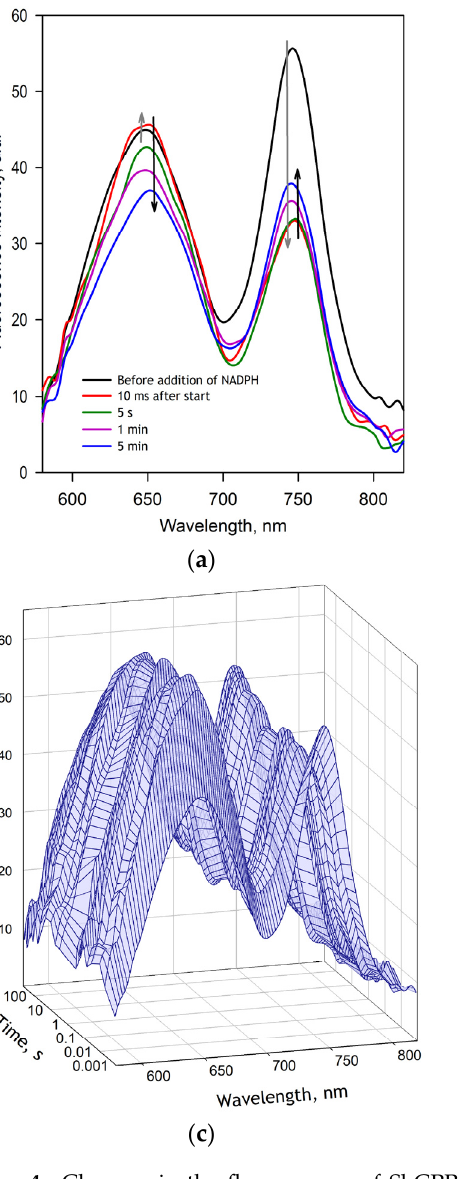
Figure 4. Changes in the fluorescence of SbCPR-2DY in the process of its NADPH-dependent reduction studied by rapid-scanning stop-flow spectroscopy. Panel ( a ) shows a representative set of spectra of fluorescence with excitation at 505 nm registered at different time points. Here, the gray arrows indicate the direction of the changes during the initial 100 ms of the process. Black arrows indicate the direction of the changes during the latter phase of reduction. A series of spectra of fluorescence recorded at the same time points with the direct excitation of the acceptor at 617 nm is shown in panel ( b ). Panel ( c ) illustrates the spectral changes during the reduction as a 3D plot of fluorescence spectra (excitation at 505 nm) normalized on the integral fluorescence intensity. A kinetic curve of the changes in FRET efficiency during the reduction is shown in panel ( d ) in semi-logarithmic coordinates. The solid line shown in this plot corresponds to the approximation of this data set by a three-exponential equation.